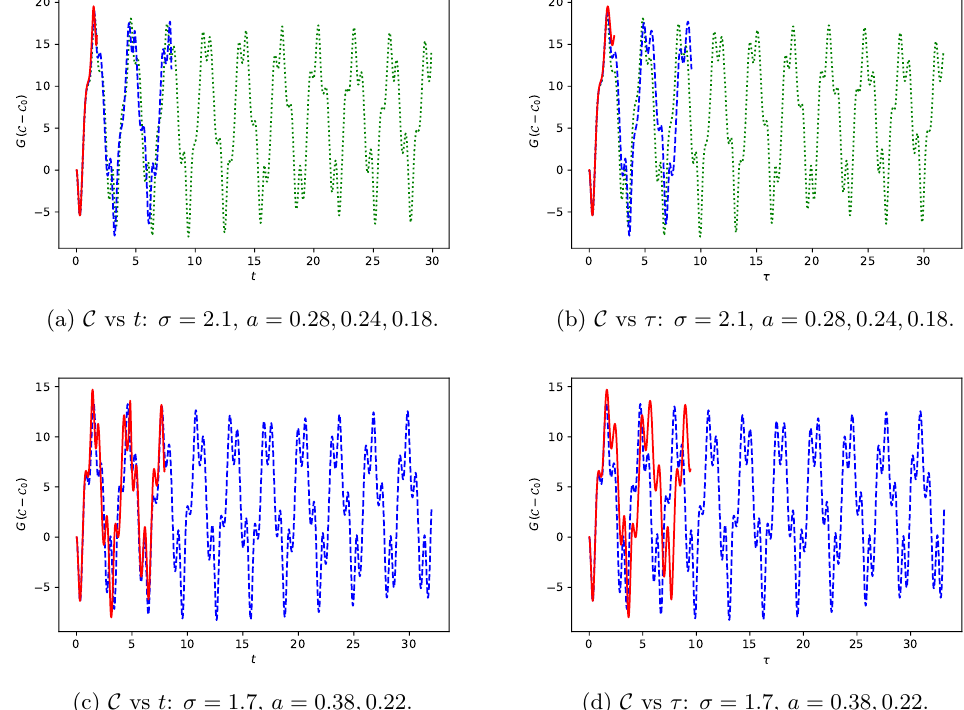
Figure 3. Volume complexity vs t and τ for two sets of initial data. Both are massless scalars in AdS 5 . Curve for the largest amplitude in each figure is solid red, next is dashed blue, and next is dotted